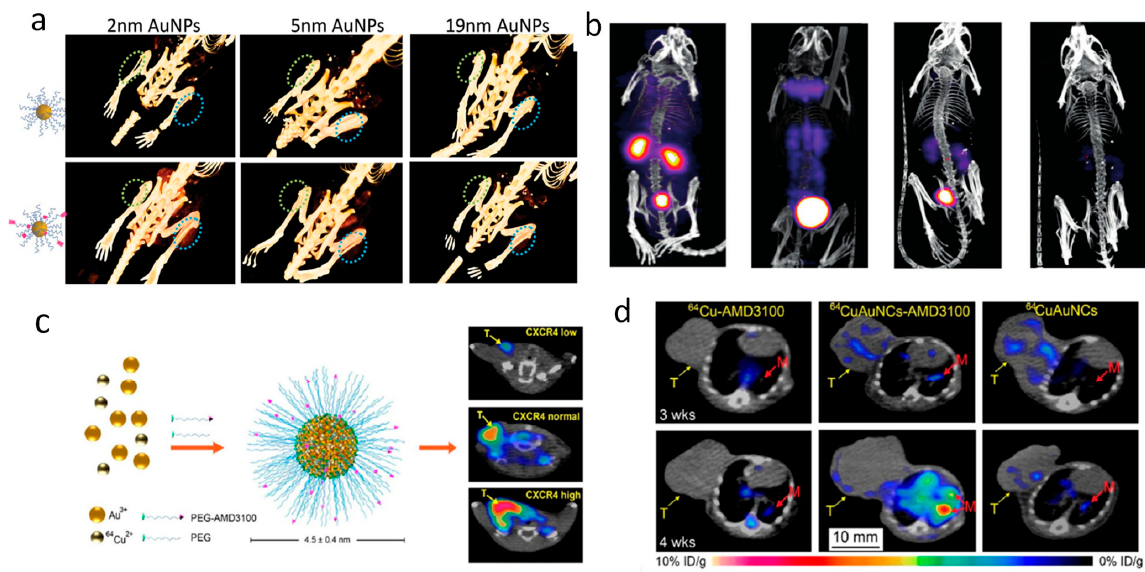
Figure 2. ( a ) Selective tumor accumulation of PSMA-targeted AuNPs (bottom panel) to PSMA-expression PC3pip tumors (blue circles) over non-expressing PC3flu tumors (green circles) with NPs sizes of 2 nm, 5nm and 19 nm vs. non-targeted AuNPs with the same sizes (top panel) at 4 h post-injection. Adapted with permission from [65], published by The Royal Society of Chemistry. ( b ) SPECT images of balb/c mice at 10 min, 1 h, 4 h, and 24 h post-injection of GS-[ 198 Au]AuNPs. Adapted with permission from [66], published by Wiley. ( c ) Schematic of 64 Cu-doped AuNCs with AMD3100 targeting ( 64 CuAuNCs-AMD3100) for PET imaging of breast cancer. ( d ) PET/CT imaging of breast cancer lung metastasis with 64 CuAuNCs-AMD3100, 64 CuAuNCs alone and free 64 Cu-AMD3100 at 3 and 4 weeks after tumor implantation. Adapted with permission from [68], published by American Chemical Society.